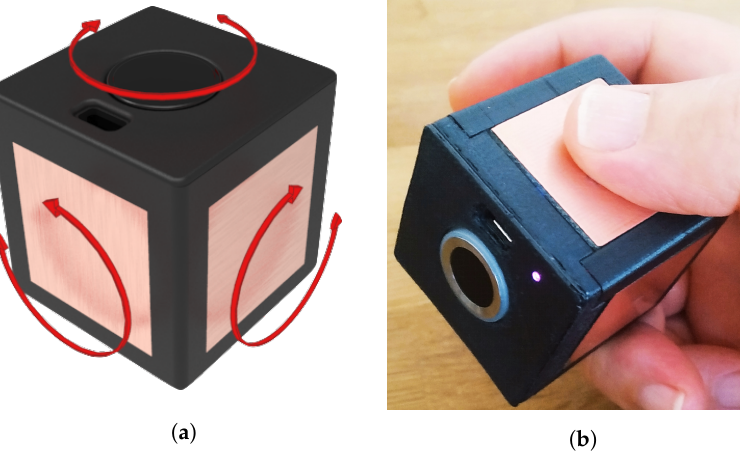
Figure 1. The possible TactCube rotations: ( a ) rotations axes; ( b ) hand